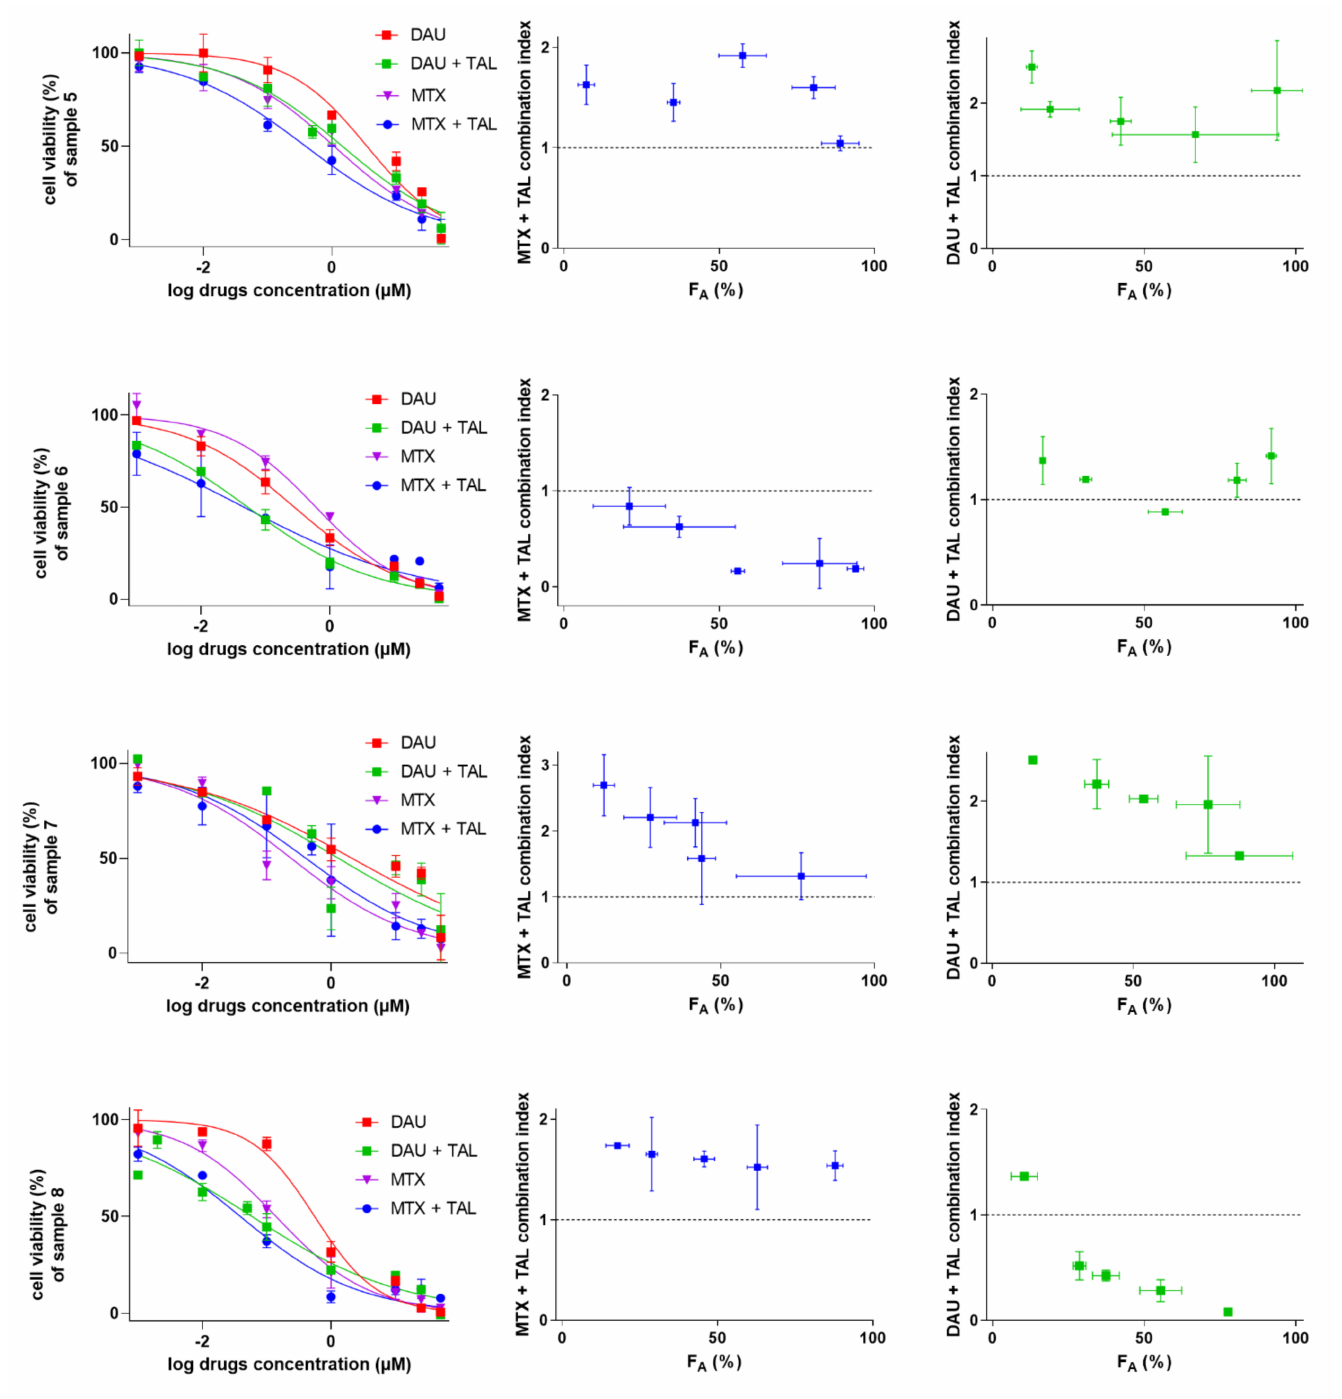
Figure 7. Talazoparib shows MDR-modulatory properties in patient-derived NSCLC primary cultures. ( A ) Western blotting analysis of ABCG2 and ABCC1 expressions (quantitative densitometric analysis on the left, representative pictures on the right). ( B ) Accumulation of mitoxantrone and daunorubicin in the presence of 5 µ M talazoparib or probe inhibitors (2 µ M Ko143 and 25 µ M MK571 for ABCG2 and ABCC1, respectively). One-way ANOVA followed by Dunnett’s post hoc test was used for statistical data analysis (* p < 0.05; ** p < 0.01; *** p < 0.001; **** p < 0.0001 compared to control). ( C ) Results of MTT-based combination assays coadministering talazoparib (5 µ M) with